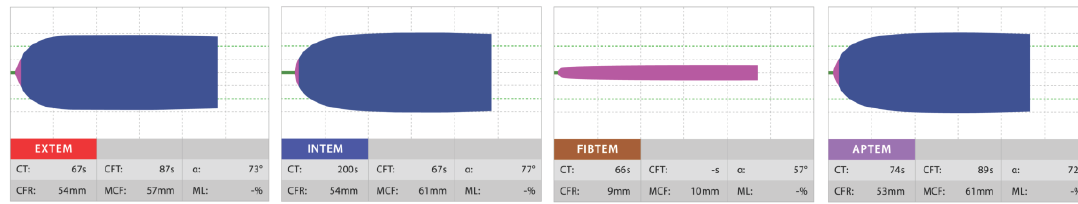
Figure 2. Picture of the ROTEM ® temogram displaying the four channels EXTEM , INTEM , FIBTEM and APTEM . Reprinted with the kind permission from the Instrumentation Laboratory, Bedford, MA, USA.